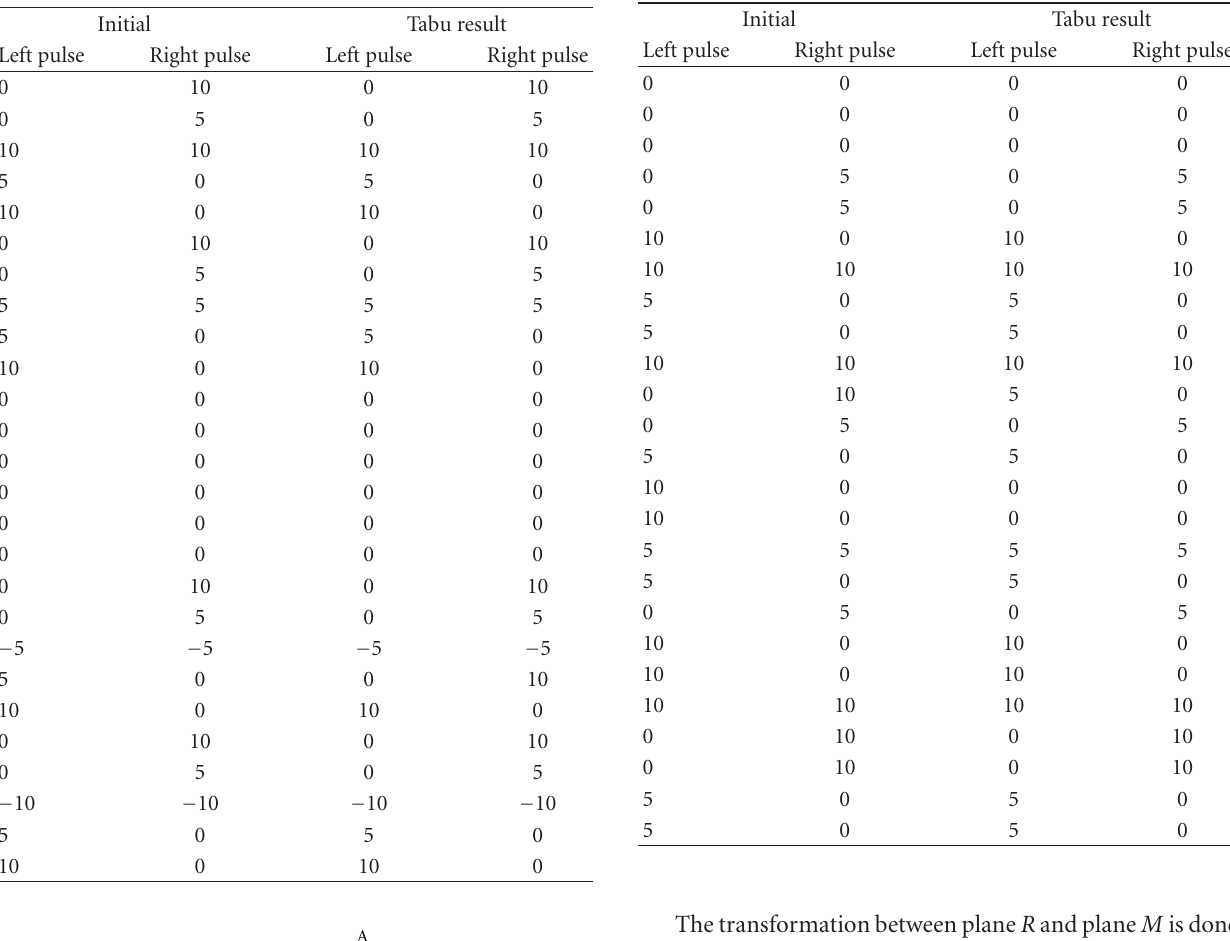
Table 1: Tabu method results for the proposed FAM.